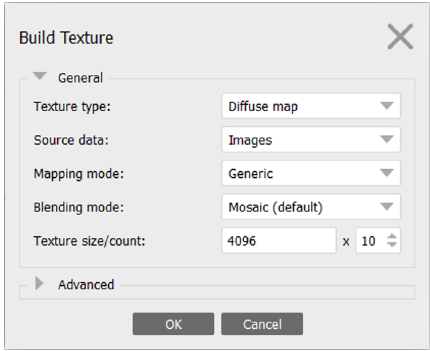
Figure A3. Texture generation parameters in Agisoft